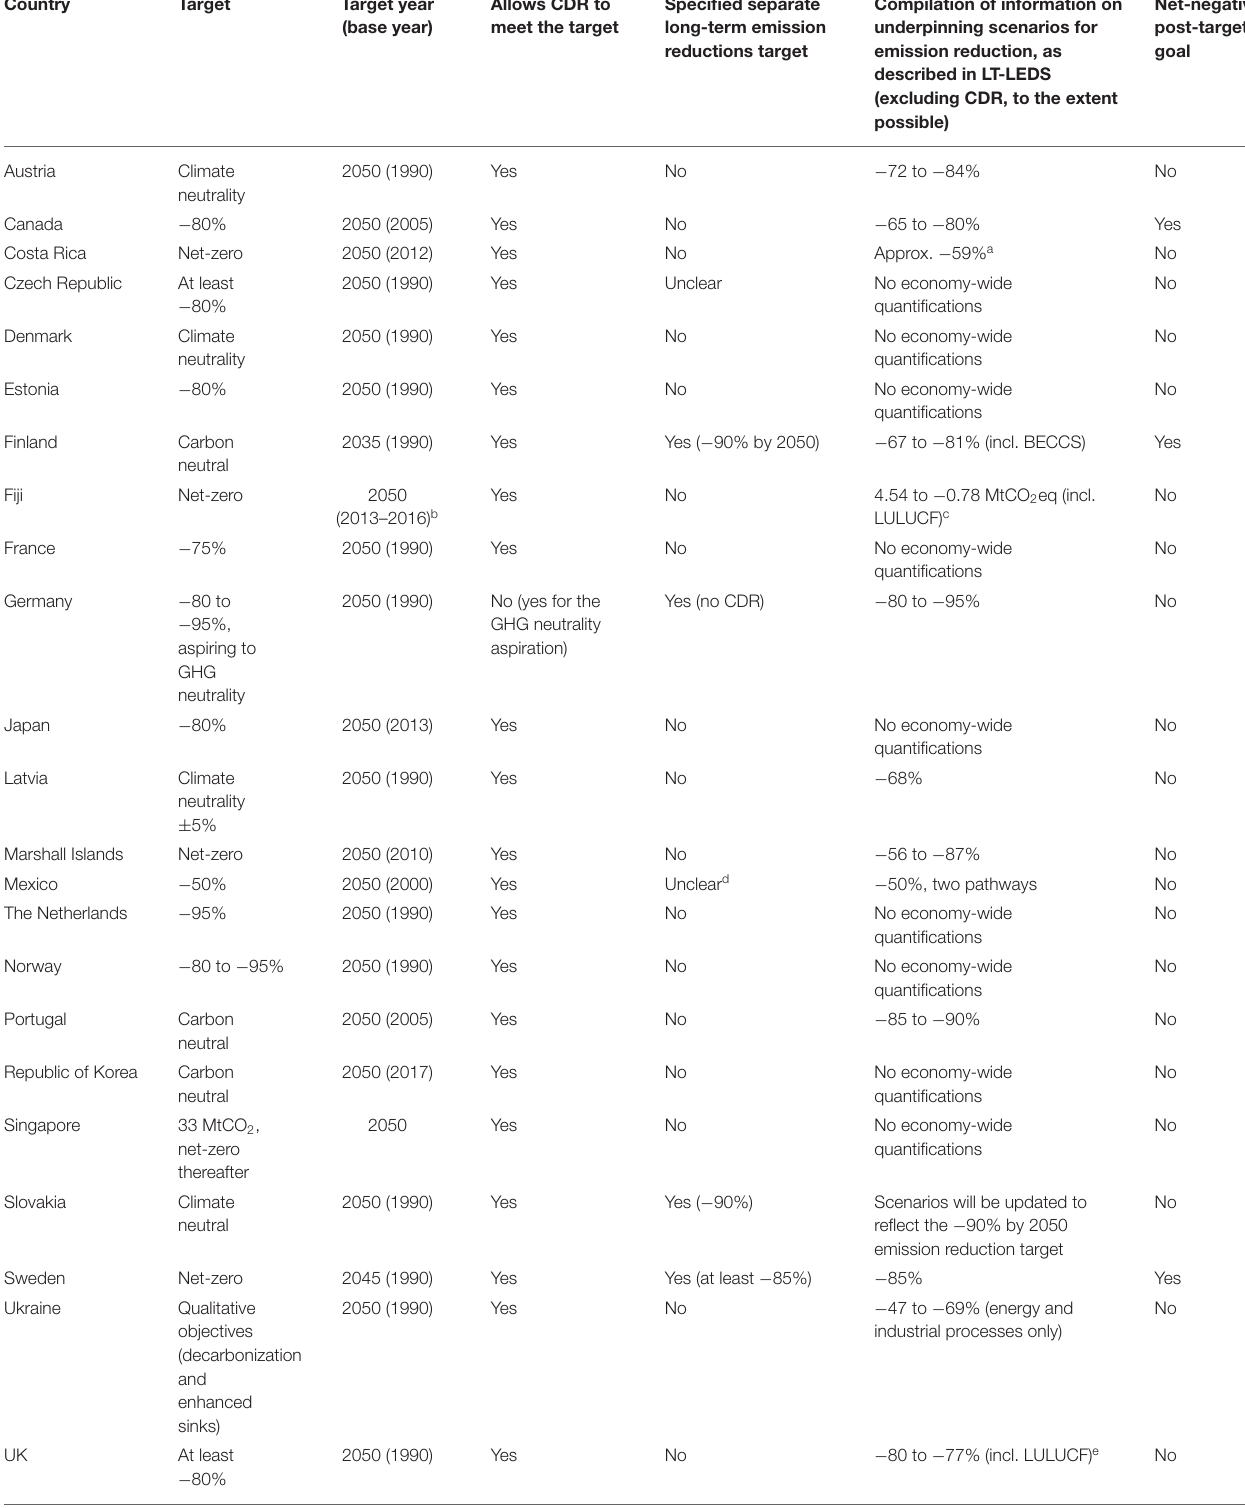
TABLE 1 | Overall target and target specification, as described in the most recent LT-LEDS submitted to the UNFCCC and to the EU.